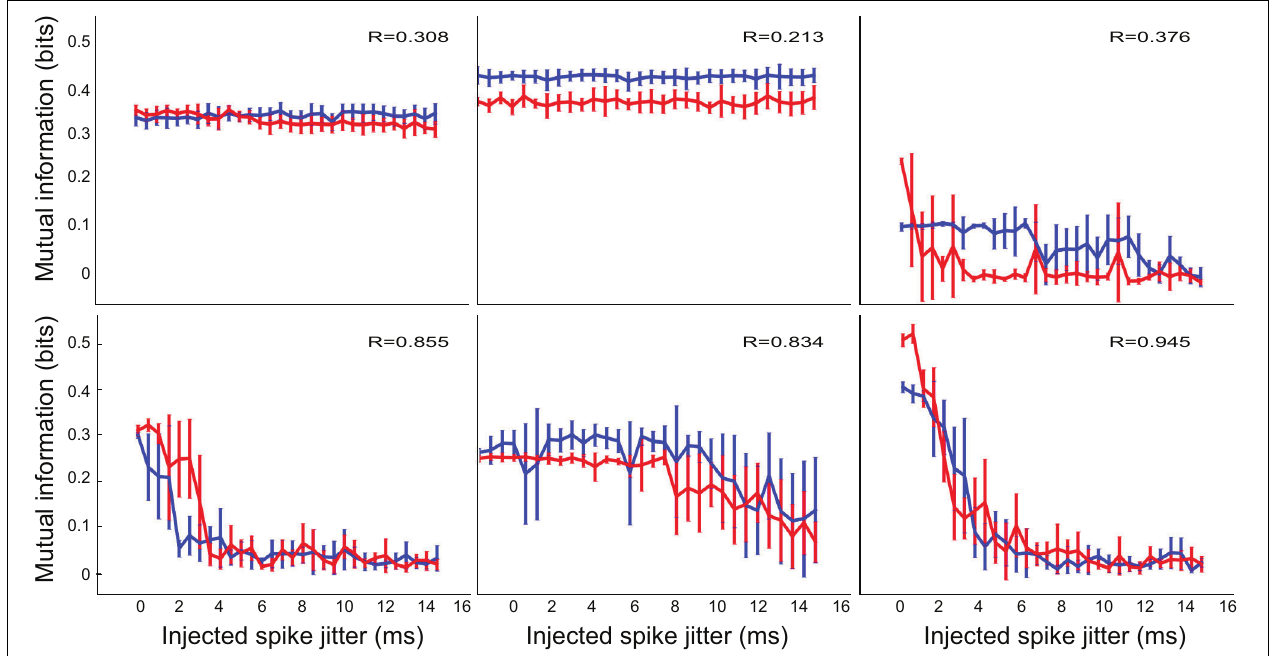
FIGURE 4 | The temporal precision of selective IC neurons was varied and not affected by inhibition. The two experimental conditions are indicated in blue (control) and red (inhibition blocked). As with the test systems, constant functions indicate little sensitivity to spike timing, while rapidly decreasing functions indicate high sensitivity to spike times. The neurons show a spectrum of temporal precision,